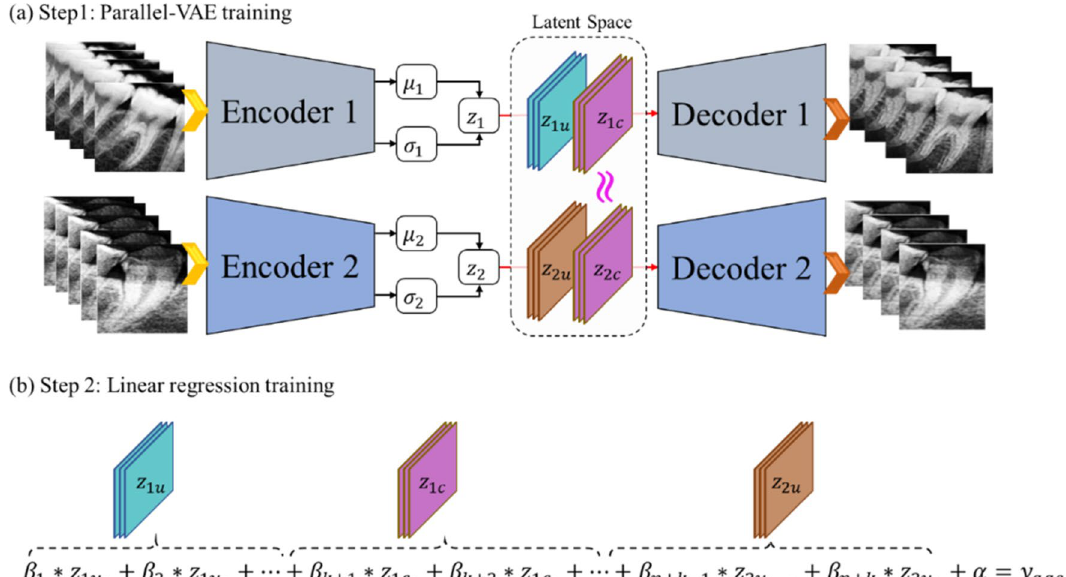
Figure 2. Structure of and training method for the parallel-variational autoencoder and linear regression model. ( a ) Parallel-VAE model that can extract common latent variables and unique latent variables from two tooth images. ( b ) Regression model that can estimate age from two unique latent variables and one common latent